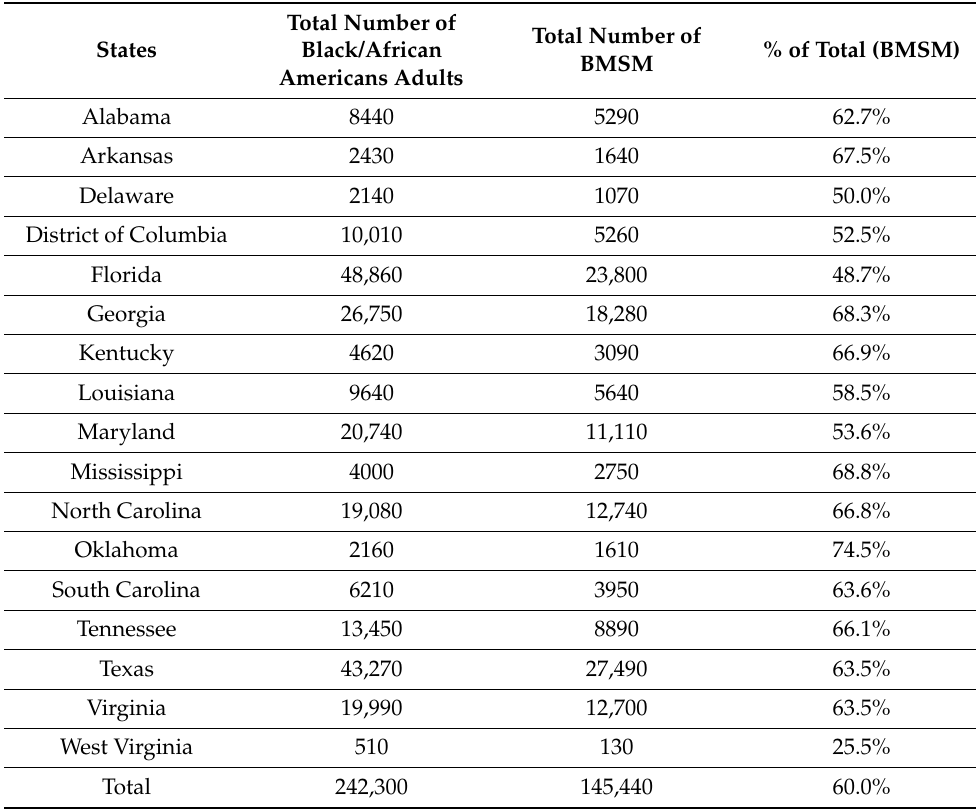
Table 2. Estimated number of BMSM with PrEP indications in the South by race/ethnicity, 2015.